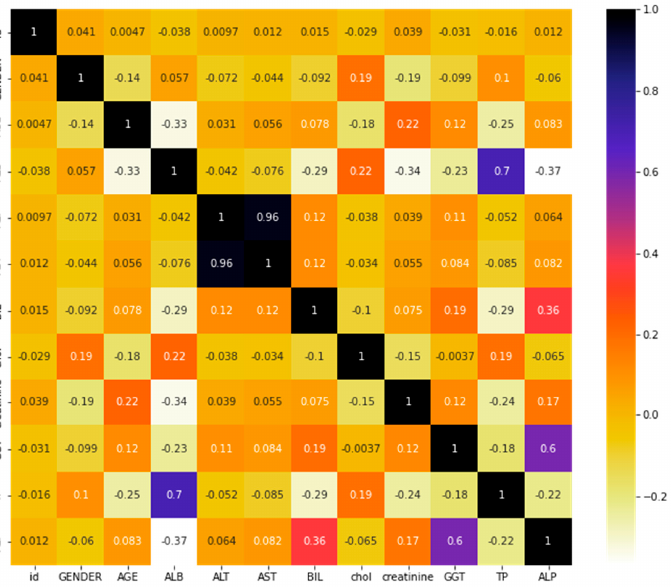
Figure 1. Simple correlation plot—HCV disease.